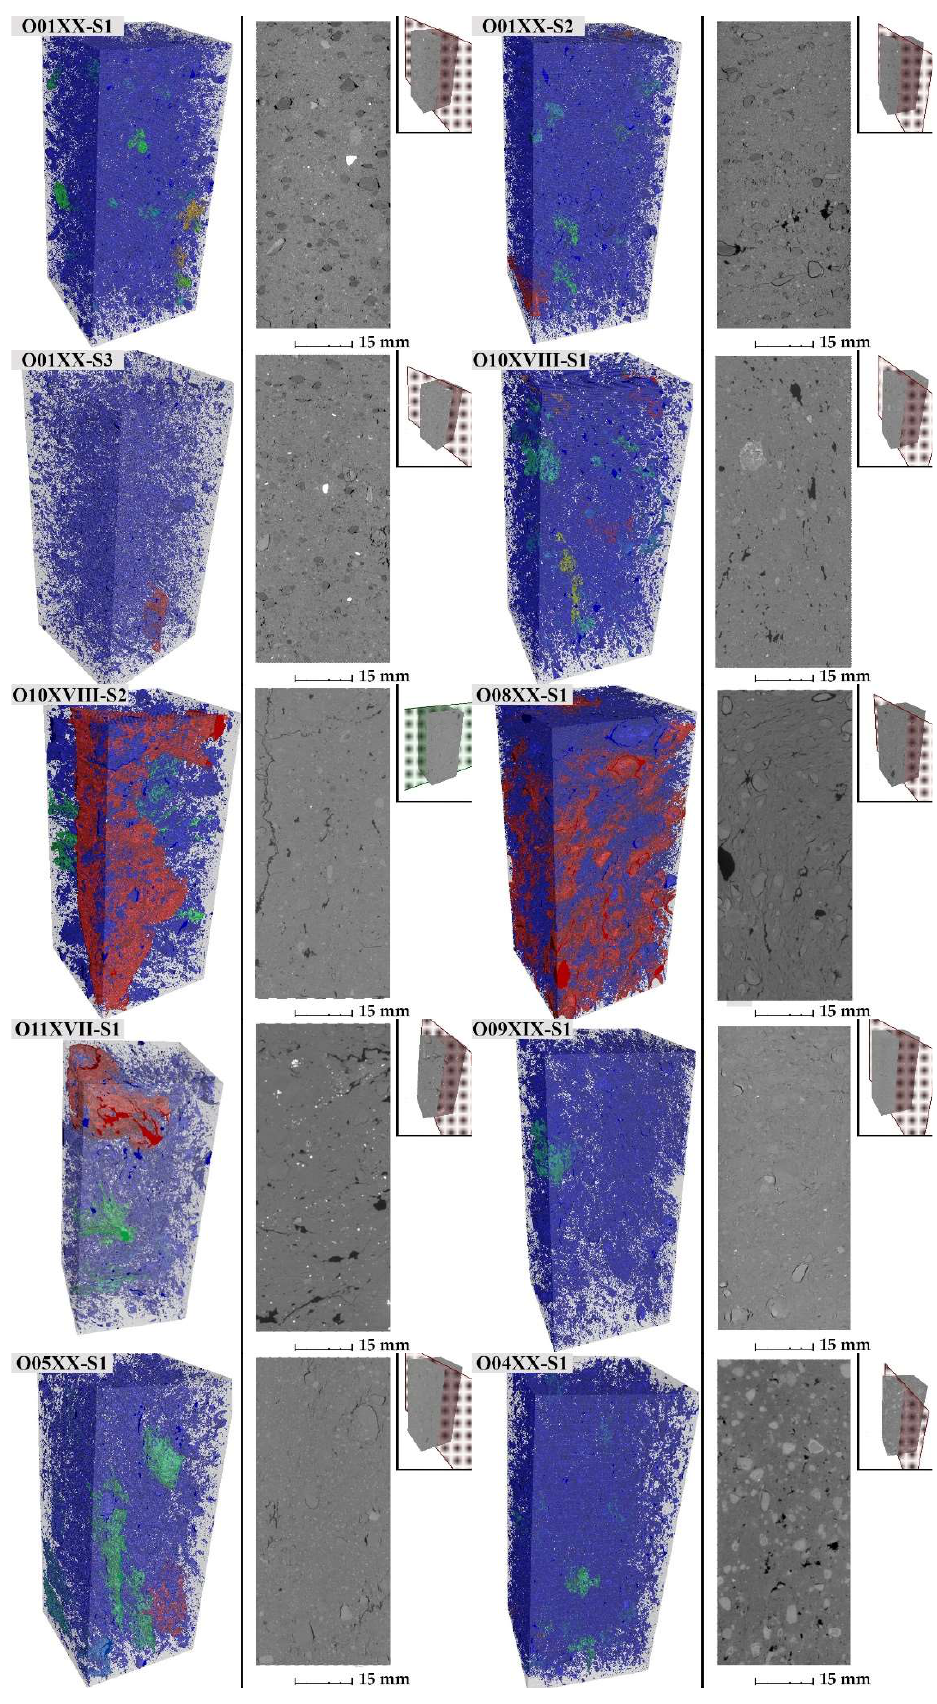
Figure 16. 3D view of the pore space from the micro-CT.